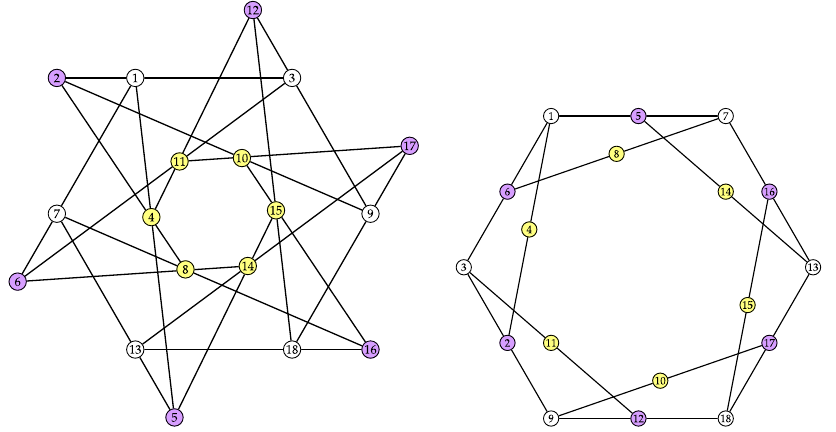
Figure 15: Two cyclic 18 318 - con fi gurations each of them with 18 triangles inducing non - isomorphic triangular matroids.